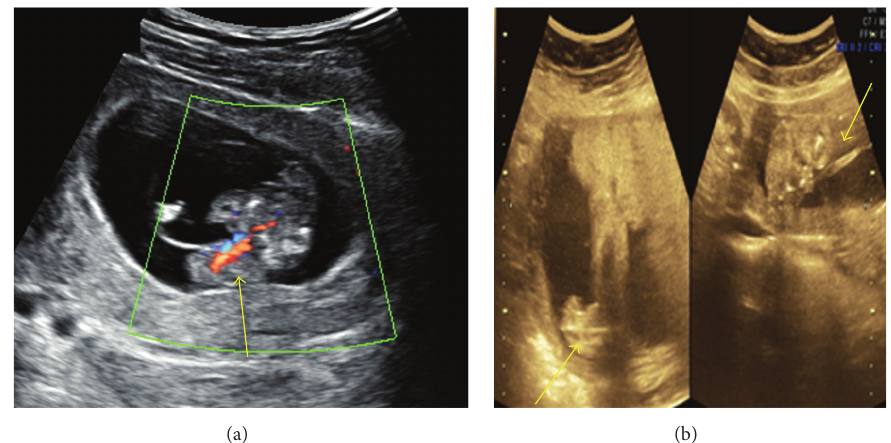
Figure 3: (a) Showing herniated liver in extra embryonic coelomic cavity. (b) Showing short lower limb with club foot and amniotic